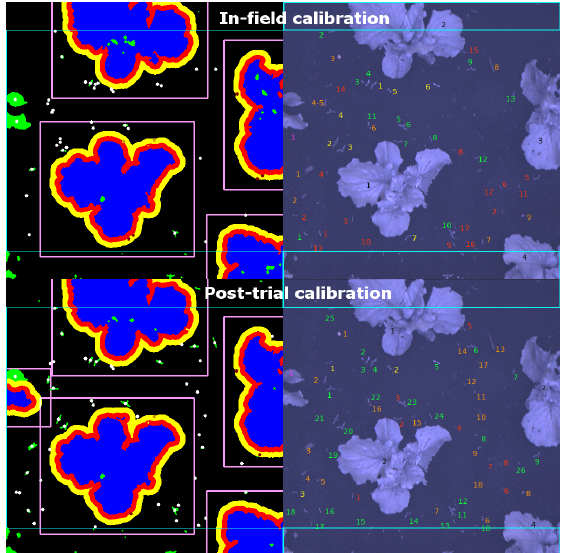
Figure 9. Images following processing ( left ) using in-field ( top ) and post-trial ( bottom ) calibration. Blue areas were designated as crops, and weeds are shown in green, with the centre of each target identified by a star. Unprocessed images are labelled by hand ( right ) according to the accuracy of the system identification using the key as defined in Table 3.